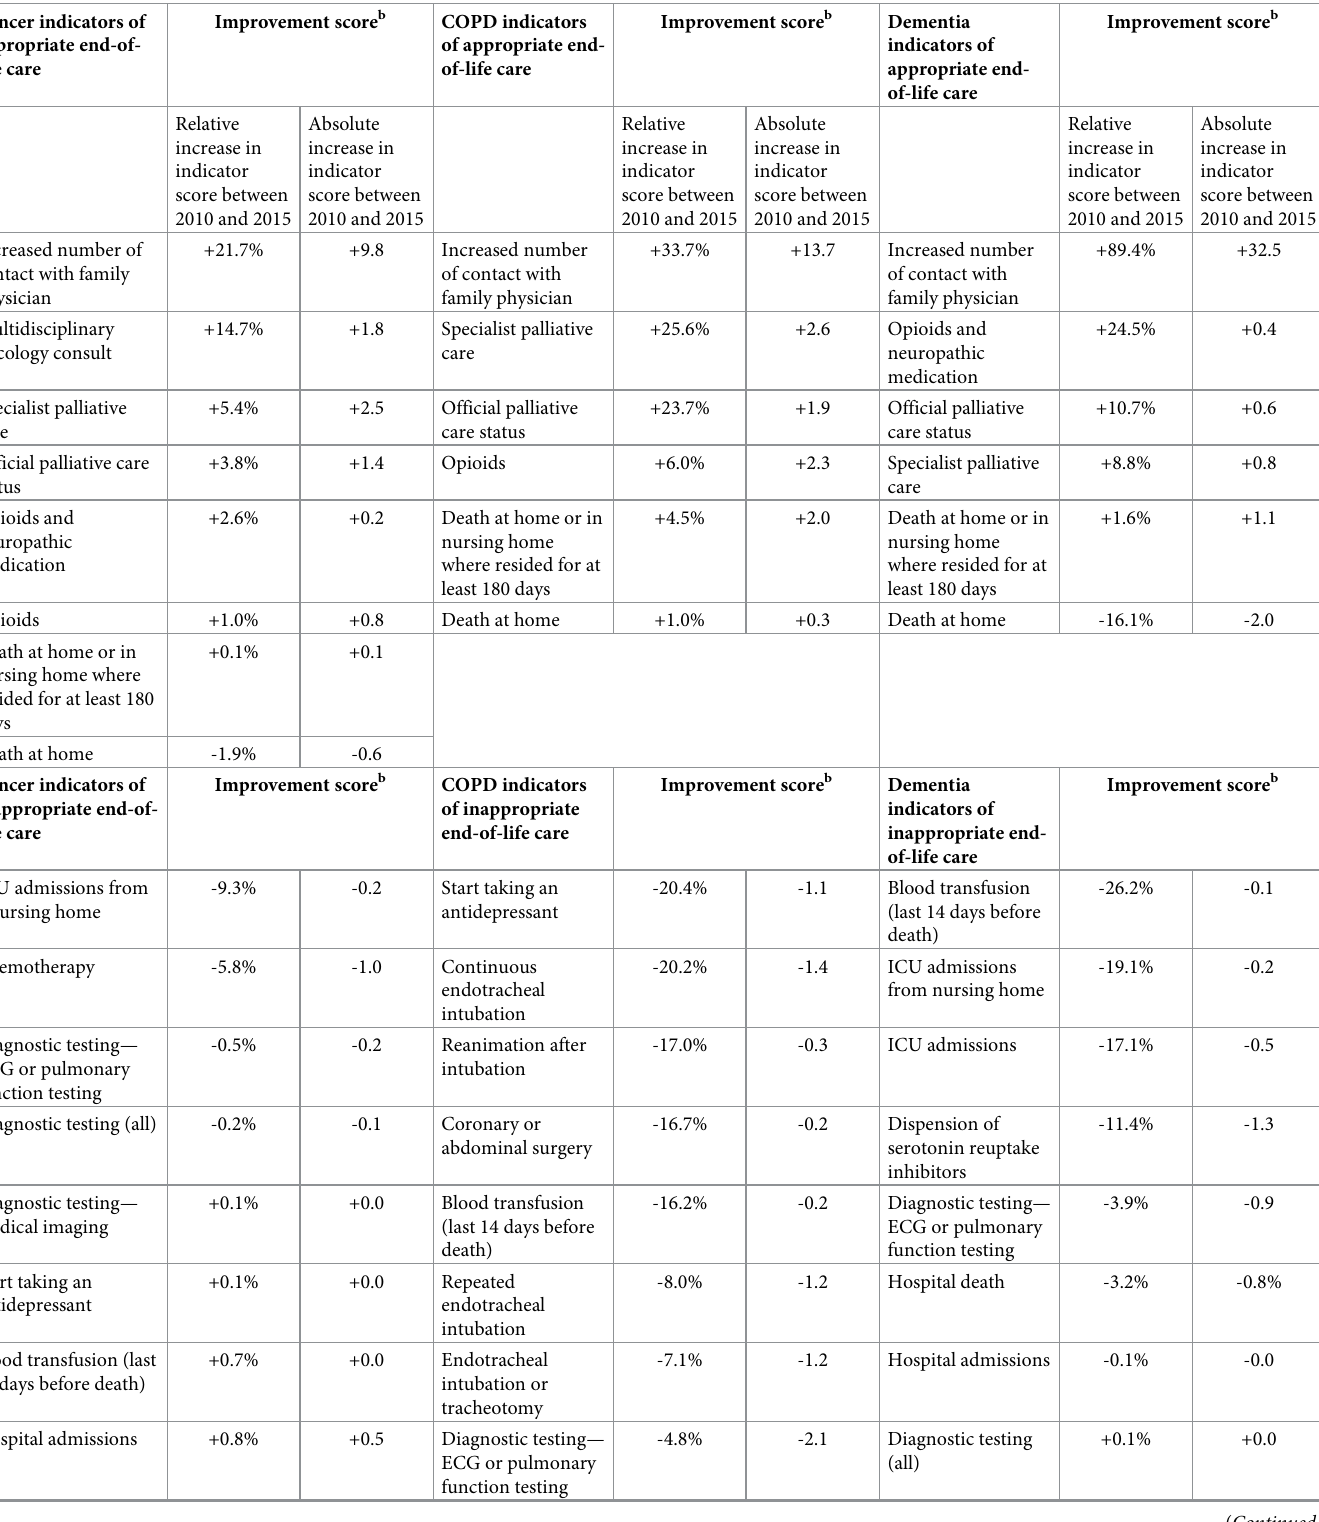
Table 2. Trends overview, containing all risk adjusted differences between 2010 and 2015, ranking all indicators a from most positive to most negative evolution in relative percentage increase b . Cancer indicators of appropriate